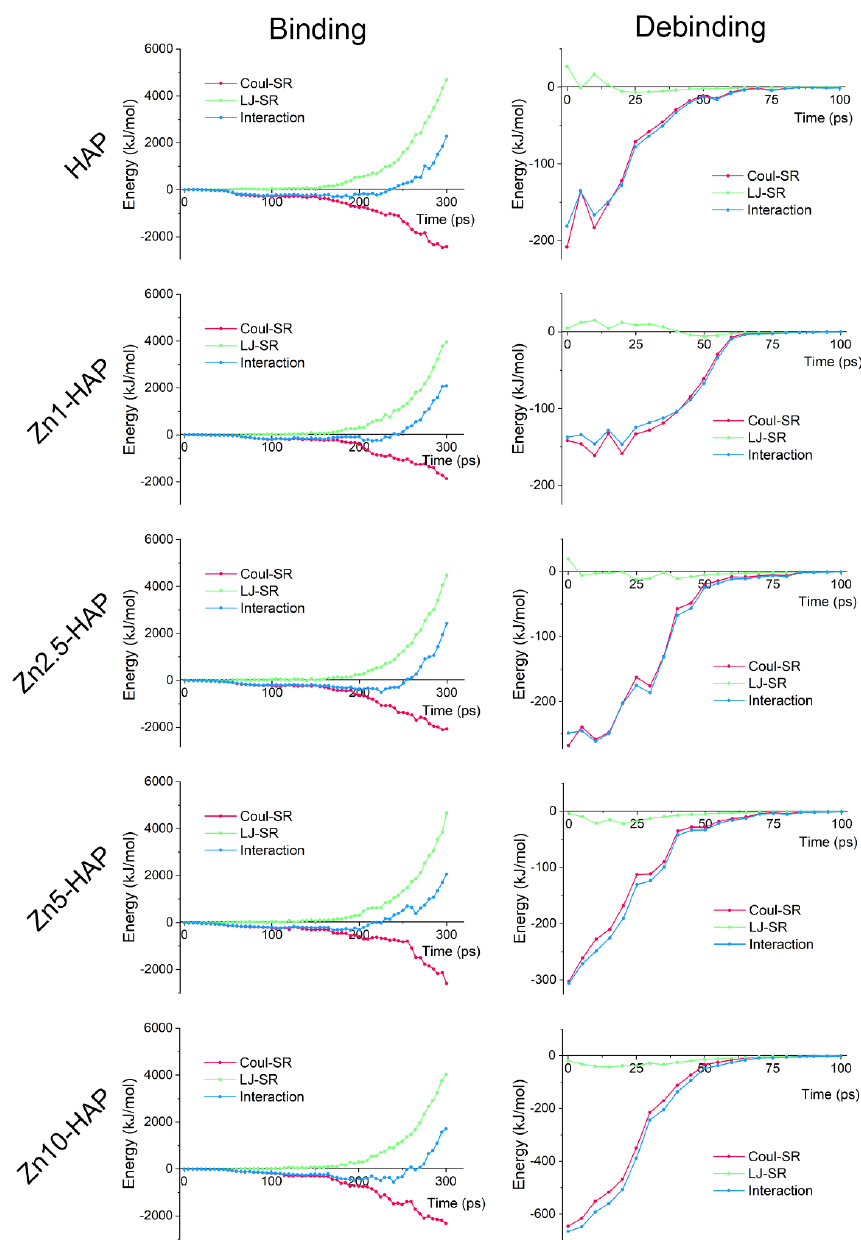
Figure 1. LJ-SR, Coul-SR, and interaction energy between BMP-2 and HAP/Zn-HAPs during